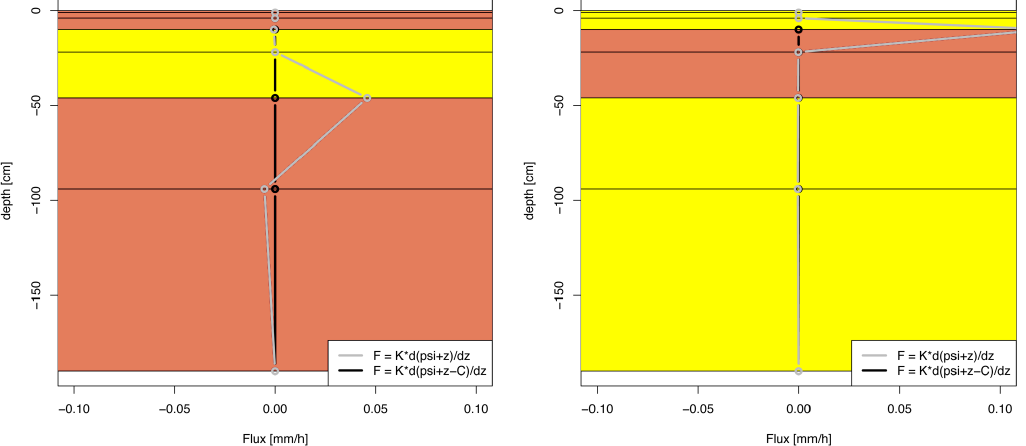
Figure 1. (left) Simulated mean water fluxes [mmh − 1 ] in a loam-sand-loam soil column after an integration period of 30 days with a WTD of 3m: the grey line shows water fluxes of the old formulation (Eq. 1), the black line of the new formulation (Eq. 6). (right) Same as (left) exept with a sand-loam-sand soil